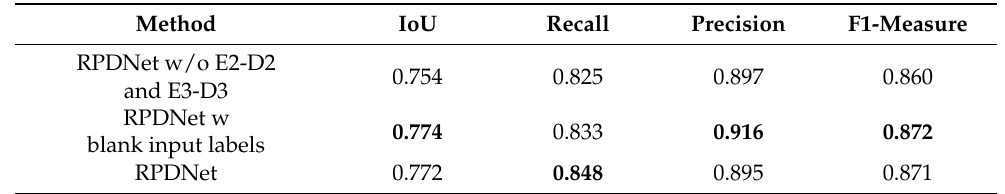
Table 6. The experiment of proposed RPDNet on repeated-pattern-free images. w/o and w stand for without and